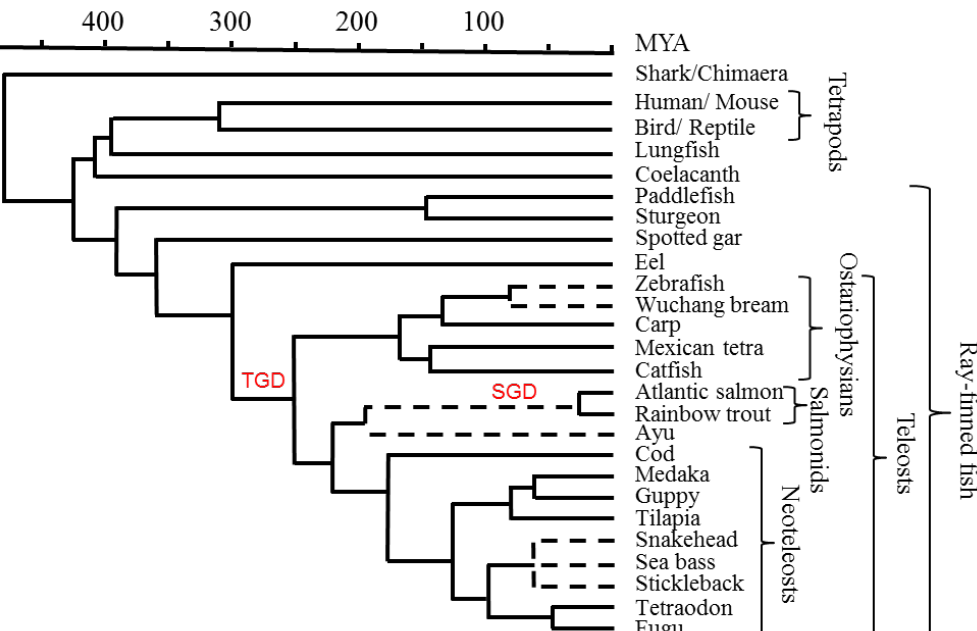
Figure 1. Phylogeny of relevant species. A timescale is depicted in millions of years ago (MYA). Dotted lines relate to phylogenetic branch knots where the referenced literature was not informative on the absolute time of the event. Whole genome duplication events in a teleost ancestor (TGD), and early in the salmonid lineage (SGD), are indicated in red font. Figure modified from [18,19].